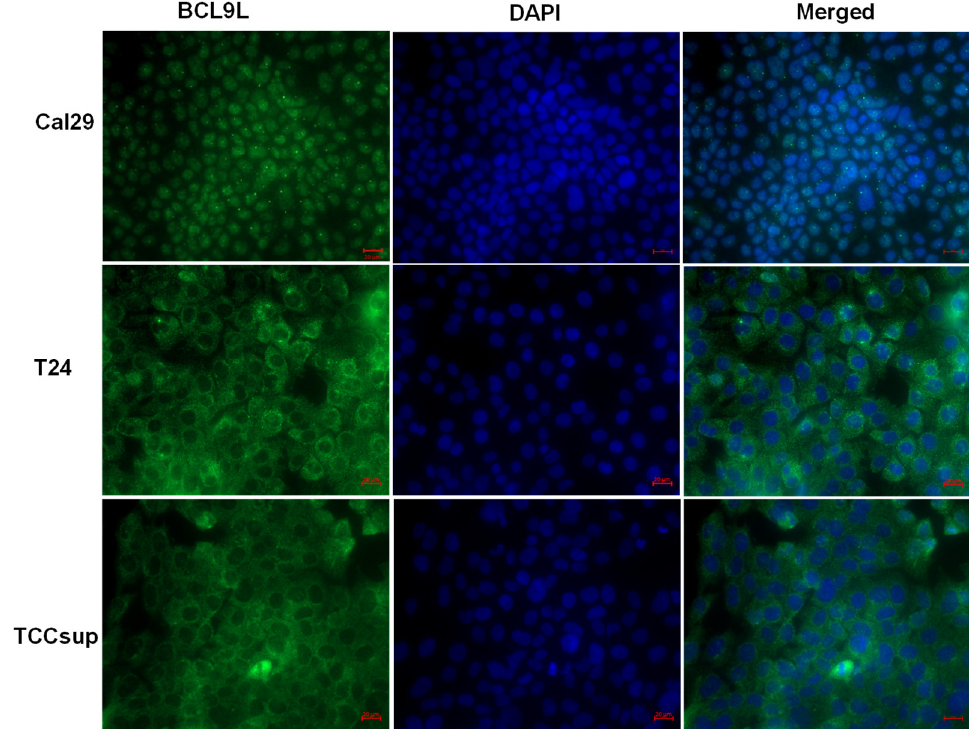
Figure 5. Intracellular localisation of BCL9L protein in bladder cancer cells. Immunofluorescence staining against BCL9L demonstrates that BCL9L is mainly localised in the nucleus of Cal29 and mainly in the cytoplasm of T24 and TCCsup cells. BCL9L is shown in green, detected by AlexaFluor ®® 488 goat anti- rabbit secondary antibody. Nuclear DNA was stained in blue with DAPI. In red is bar scale: 20 µm.